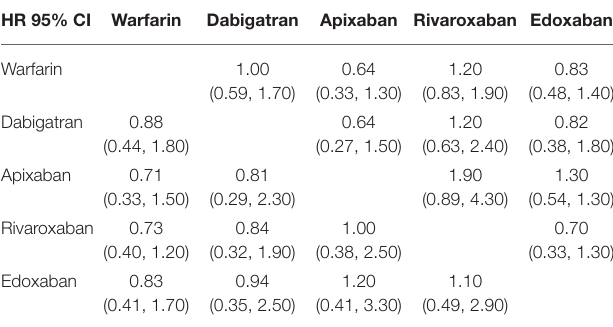
TABLE 2 | Summary of the results from network meta-analyses on efficacy and safety outcomes (lower triangle, stroke/systemic embolism; upper triangle, major bleeding).